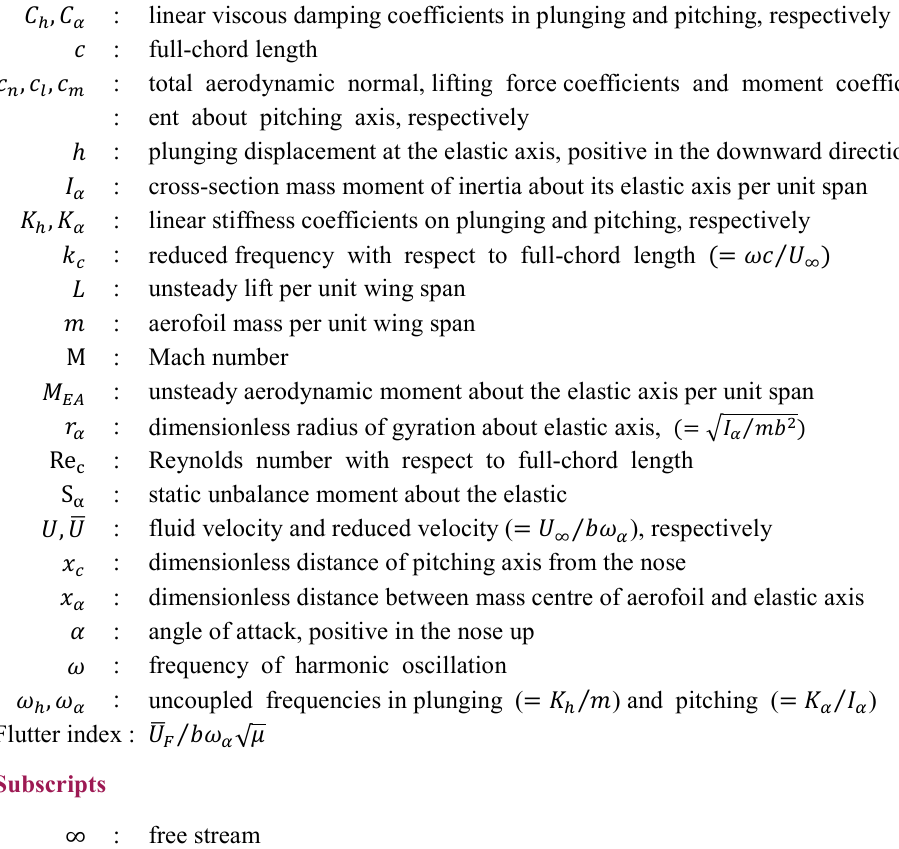
linear stiffness coefficients on plunging and pitching,